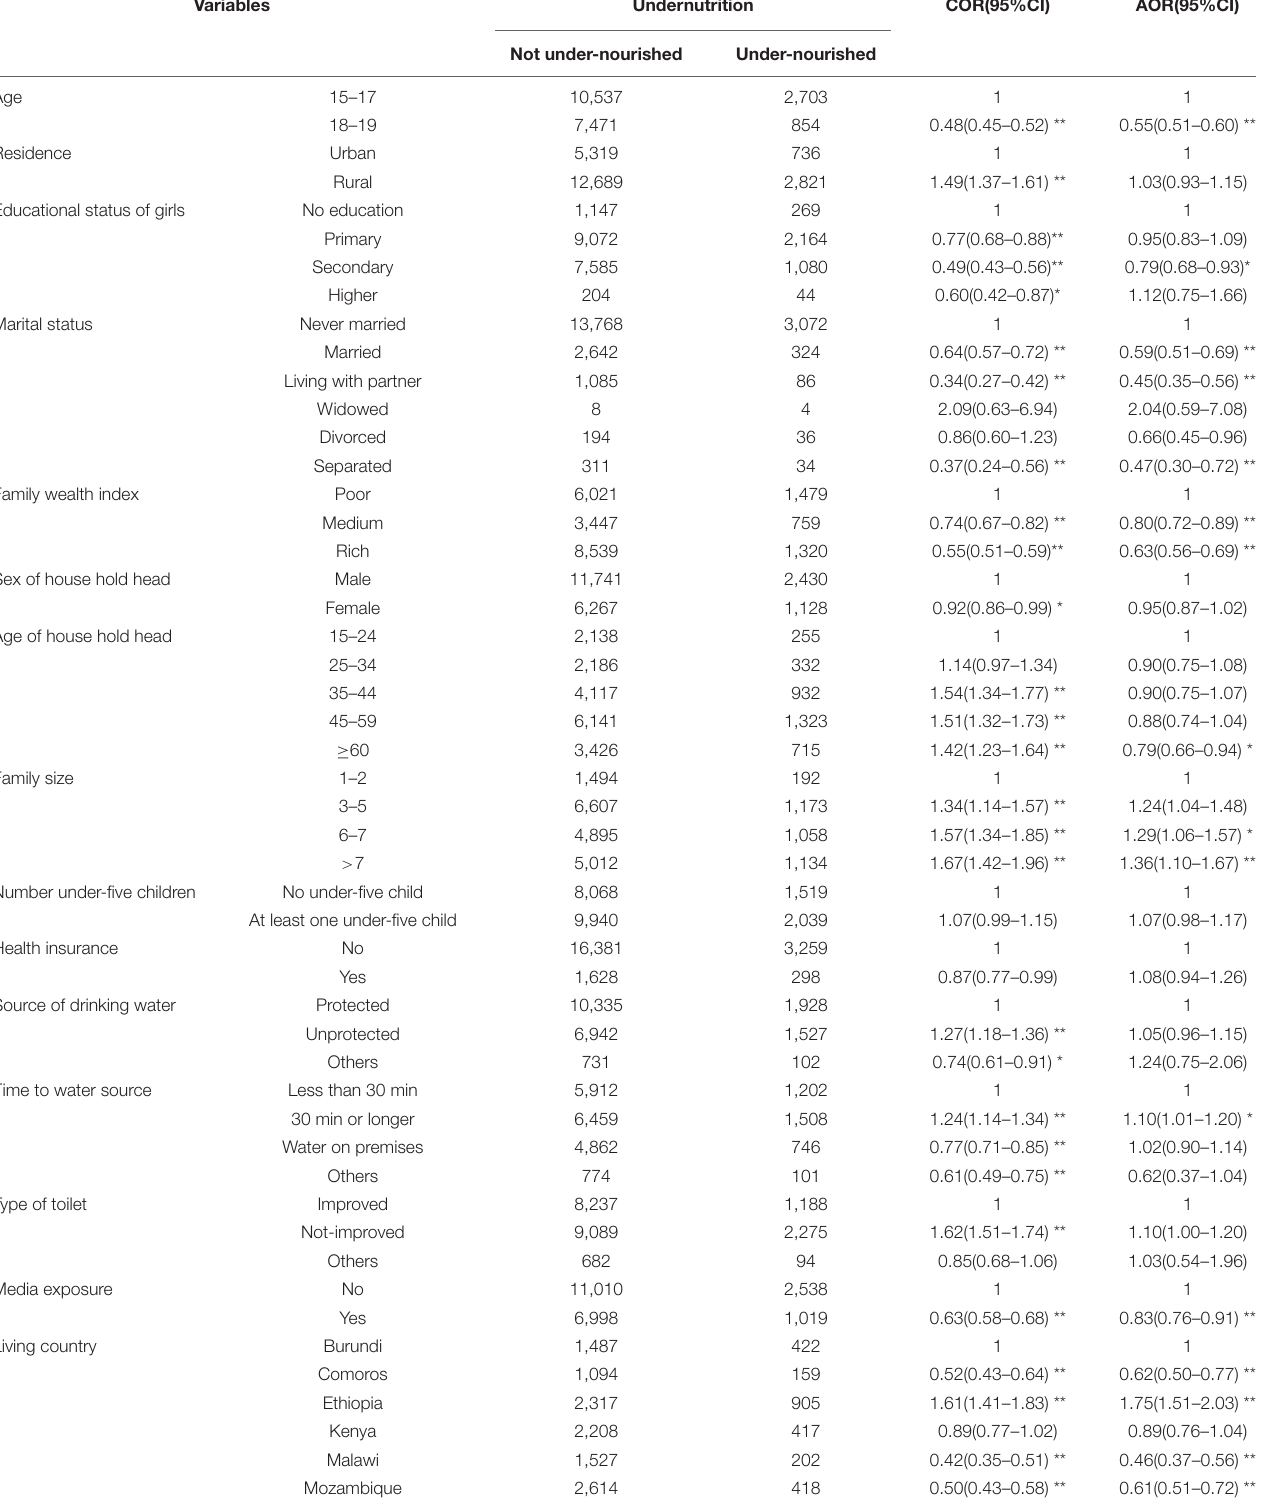
TABLE 3 | Determinants of undernutrition among late adolescent girls in East African countries